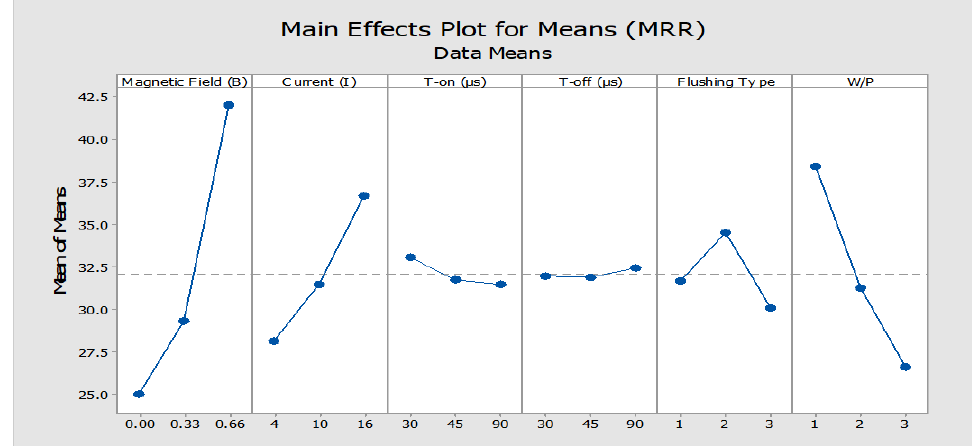
Figure 4. Main effect plot for material removal rate (mg/min).